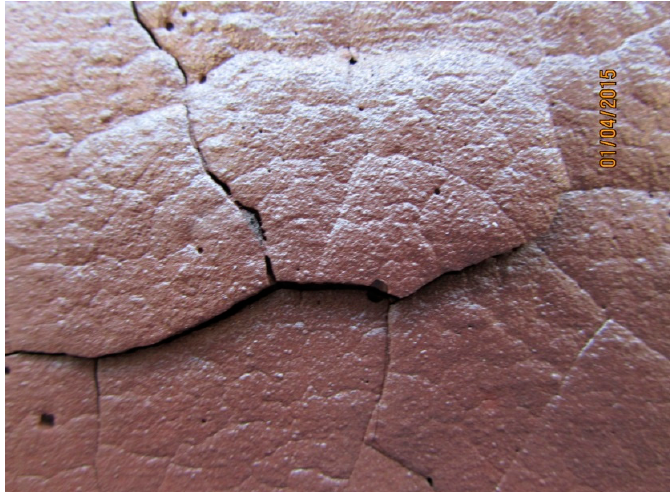
Figure 10. C1.82PP hot side close up showing lifting section attributed to differential thermal expansion/delamination. Healing of other cracks is also evident. Note that this region is clearly visible in Figure 9b and has been enlarged 1.5×.